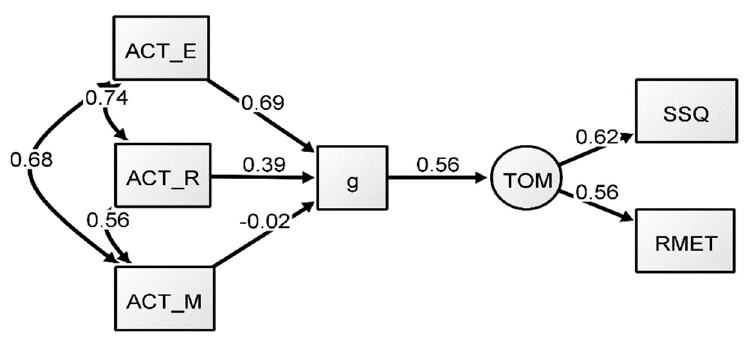
Figure 2. Formative- g SEM model (Model 2). All coefficients presented are standardized.